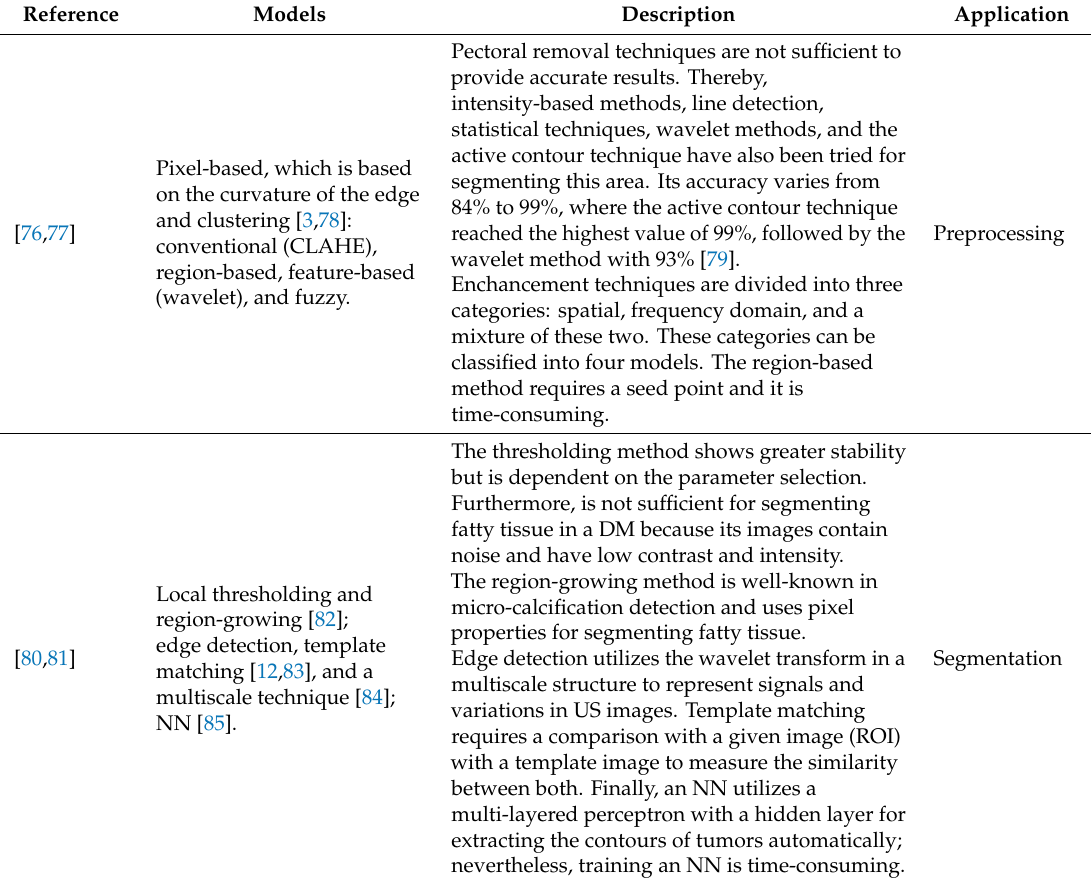
Table 2. The traditional CAD system summary with DM and US breast cancer images. It covers four stages: (i) image processing, (ii) segmentation, (iii) feature extraction and selection, and (iv) classification.